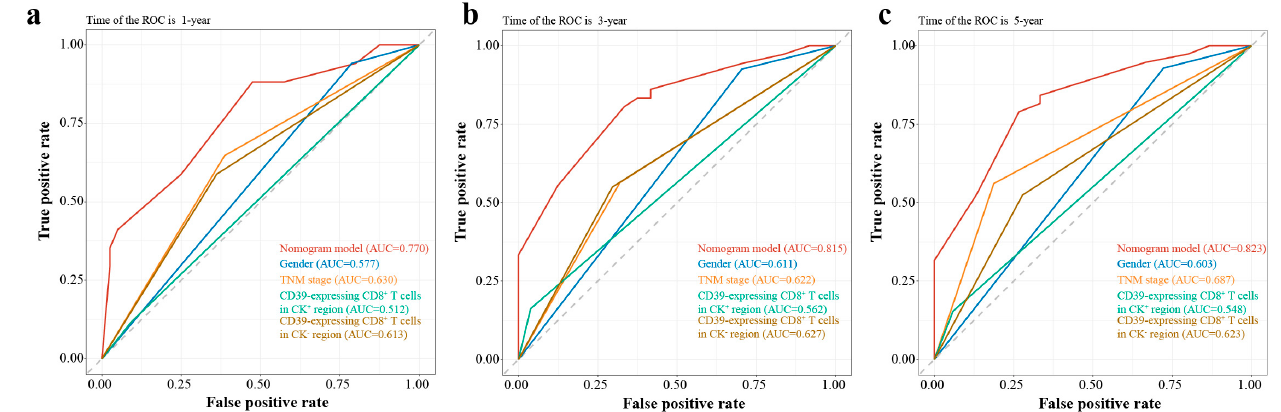
Figure 4. The AUCs at 1, 3, and 5 years of nomogram model and other independent prognostic factors of ESCC. ( a ) The 1-year AUCs of nomogram model and other independent prognostic factors of ESCC; ( b ) The 3-year AUCs of nomogram model and other independent prognostic factors of ESCC; ( c ) The 5-year AUCs of nomogram model and other independent prognostic factors of ESCC. AUC, area under the curve of receiver operating characteristics (ROC); CD39, ectonucleoside triphosphate diphosphohydrolase 1; CK, cytokeratin; ESCC, esophageal squamous cell carcinoma.